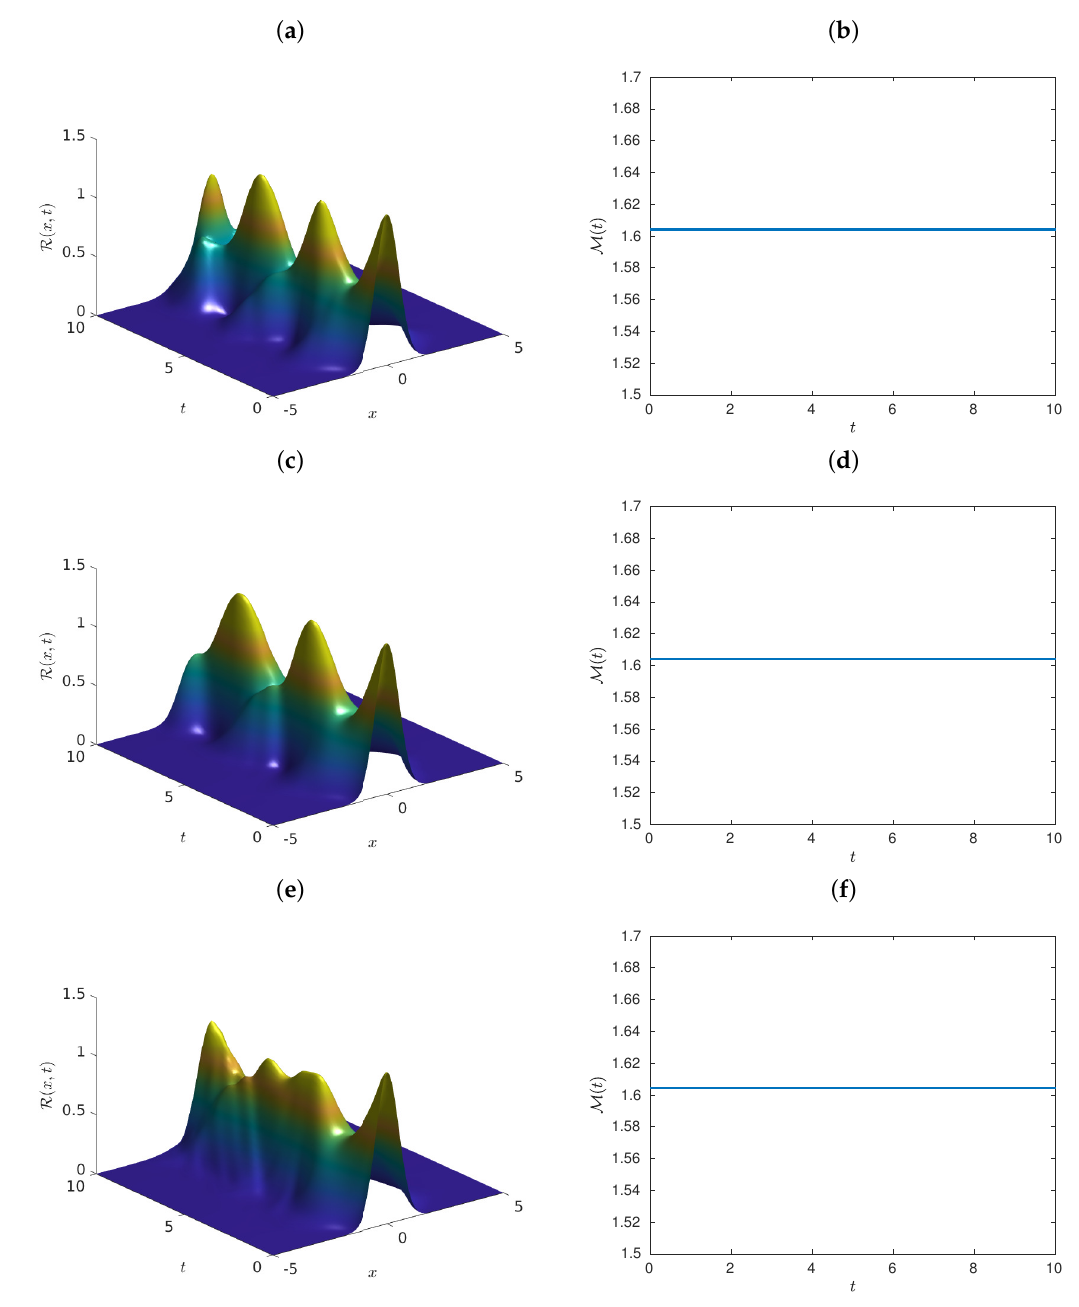
Figure 6. Approximate solutions for the problem (4) using the parameters in Table 1, and the computational time-steps h = 0.1 and τ = 0.05 for the finite-difference method (36). We used V ( x ) = 1 1 √ exp ( − x 2 ) . (left column) Approximate graphs of the discrete mass density R versus ( x , t ) . (right column) Graphs of the π total mass M versus t . We used α 1 = 1.1 and α 2 = 1.9 ( a , b ), α 1 = 1.5 and α 2 = 1.5 ( c , d ), and α 1 = 1.9 and α 2 = 1.1 ( e , f